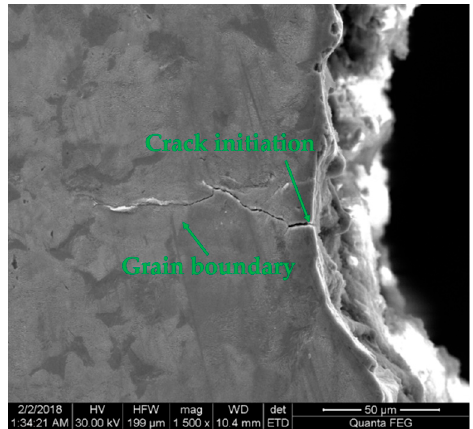
Figure 10. Optical micrographs by SEM after crack initiation.